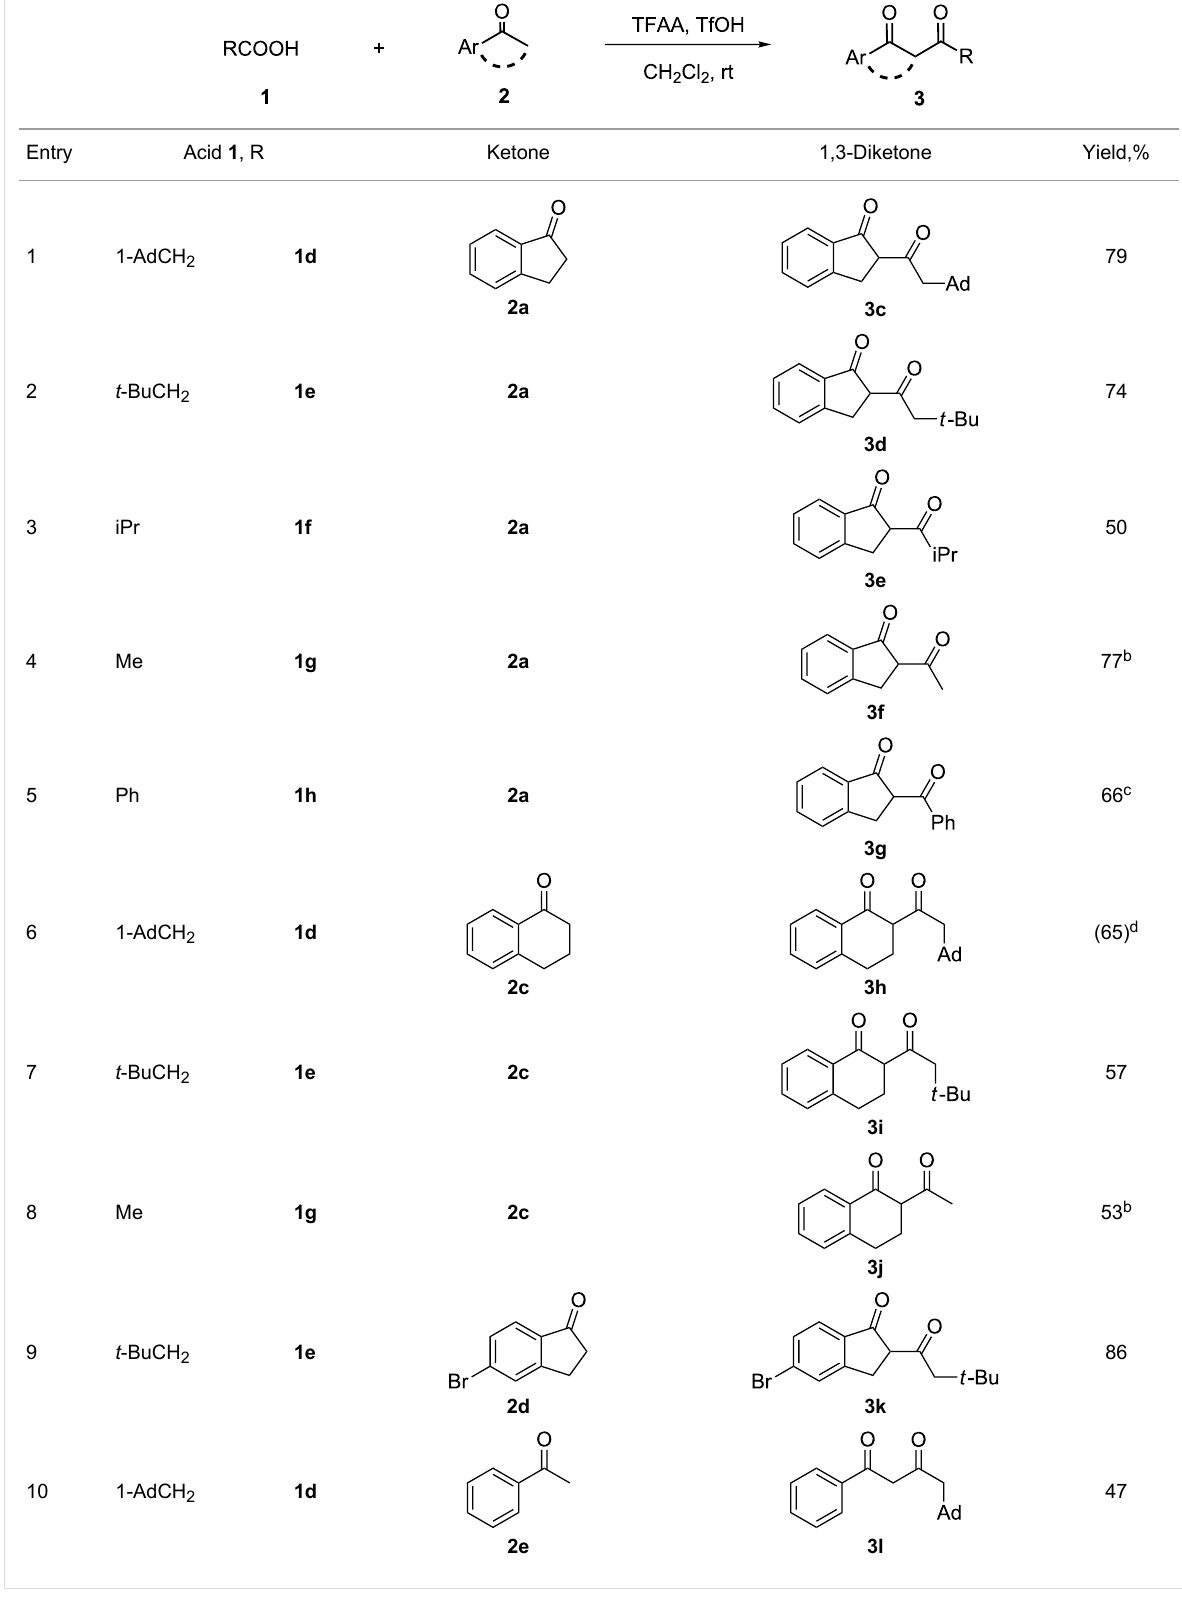
Table 2: TFAA/TfOH-mediated acylation of aromatic ketones with alkanoic acids а